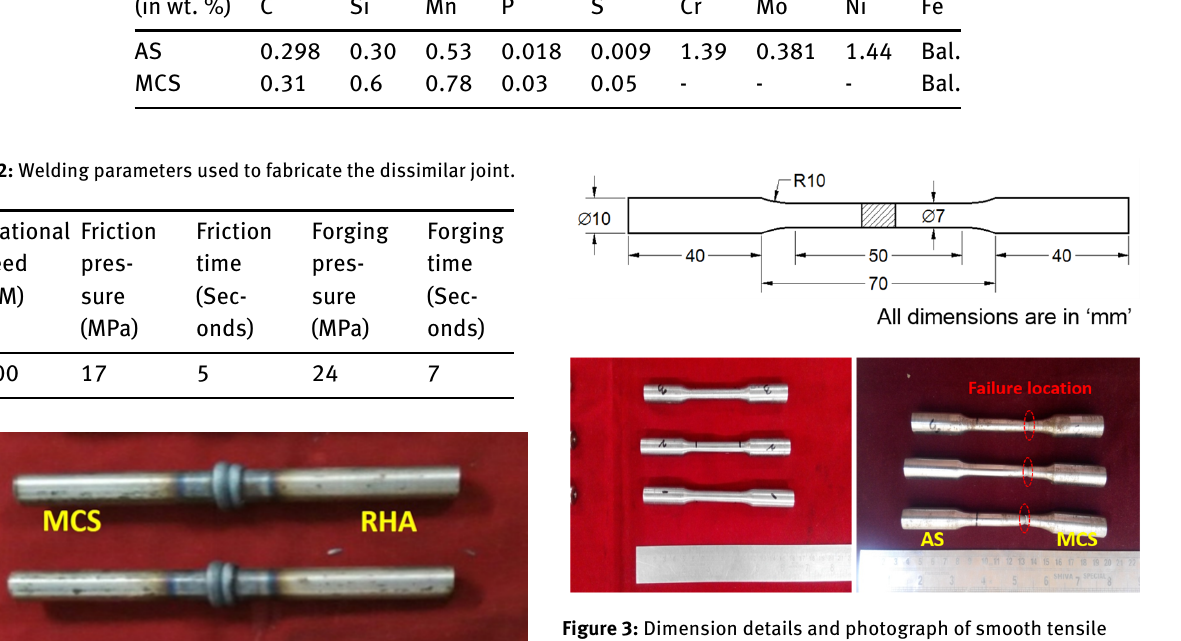
Figure 3: Dimension details and photograph of smooth tensile specimens.